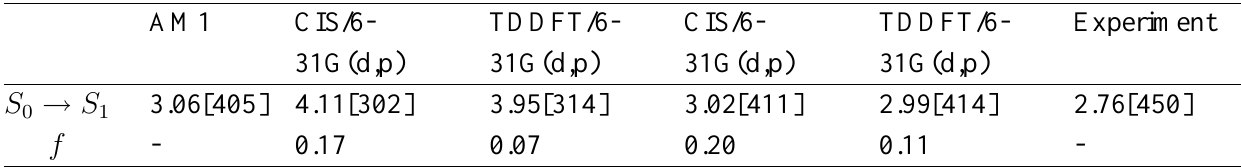
Table 2. Transition energies in eV [nm] and oscillator strengths at the excited state geometry ( S CIS energies have been scaled by a factor of 0.72. The third and fourth columns correspond to ge- ometry optimisation at CIS/6-31G(d,p) level while the fifth and sixth columns correspond to geometry optimisation at CIS/6-311G(d,p)